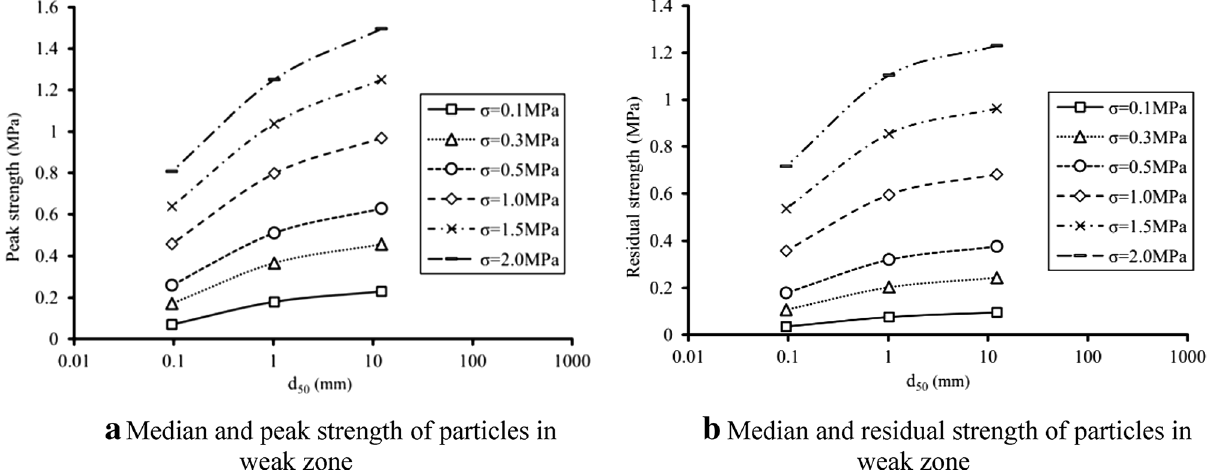
Figure 17. Influence of material crushing degree on shear strength.